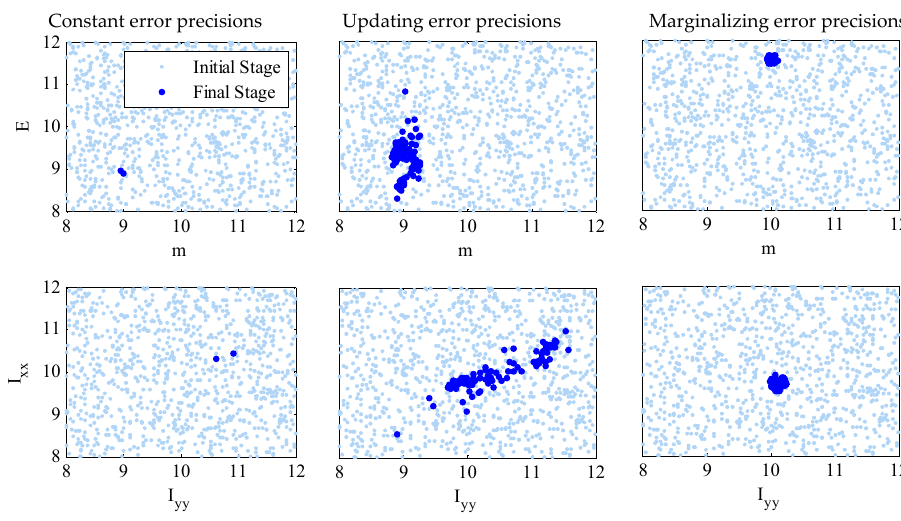
Figure 5. Samples of the initial and final stages of TMCMC for the three cases with constant, updating and marginalizing error precisions.